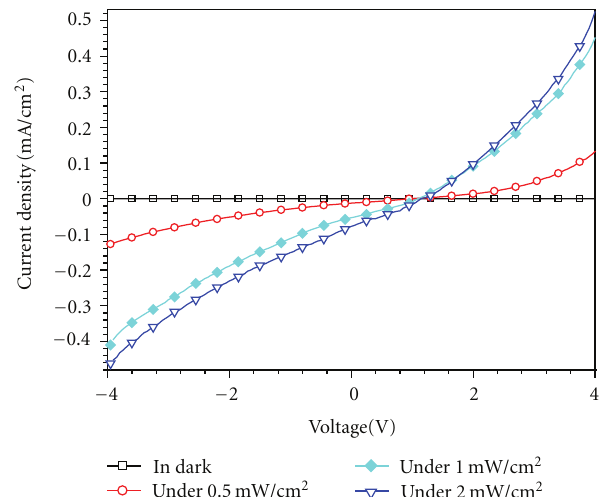
Figure 11: Current density-voltage curves of ITO/PEDOT: PSS/PFE:BNDI (3:1) at 60 ◦ C annealing temperature/Al under 0.5 mW/cm 2 , 1mW/cm 2 and 2 mW/cm 2 at 368nm UV light.